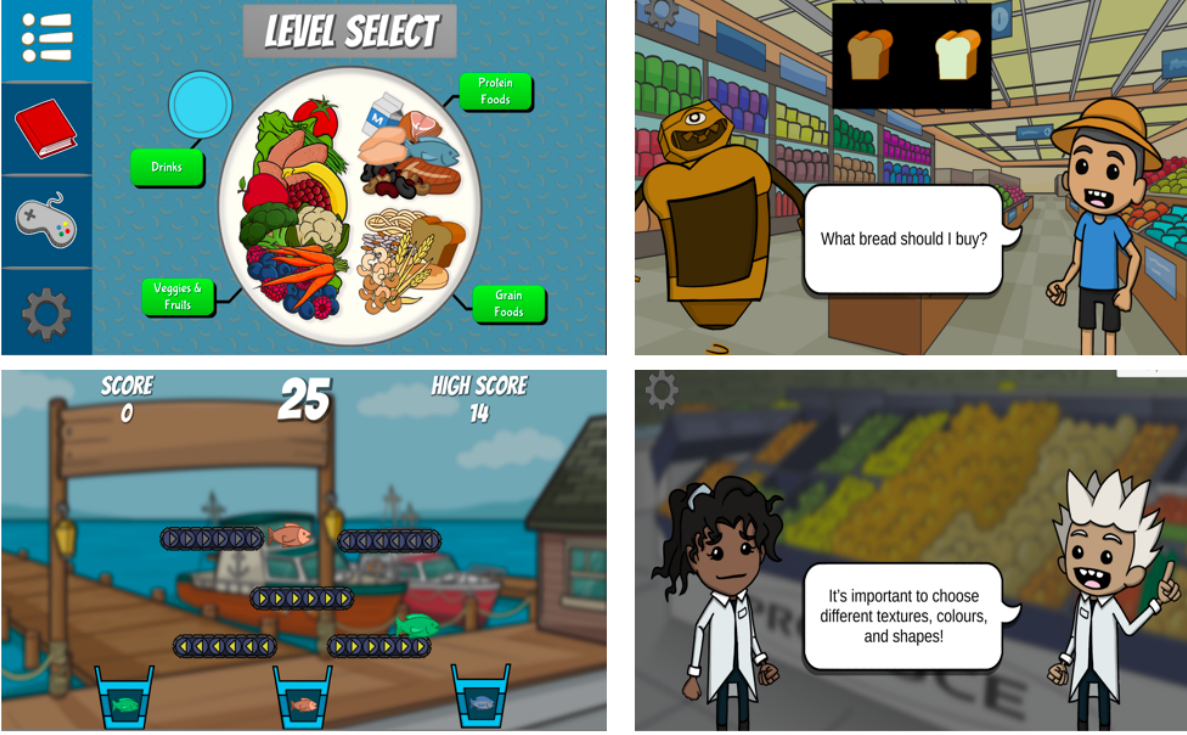
Figure 2. Foodbot Factory screenshots.